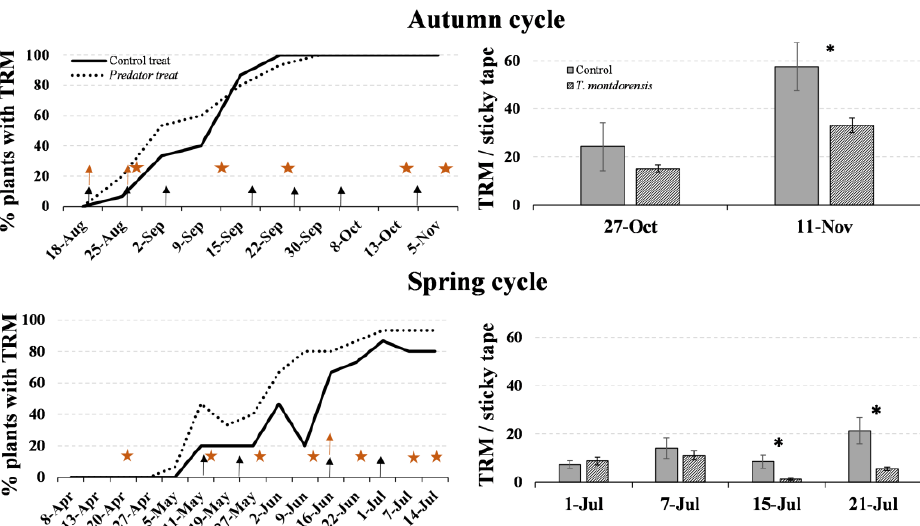
Figure 5. Percentage of plants with TRM and A. lycopersici density, measured using sticky tapes in two greenhouse tomato crop cycles, autumn 2020 and spring 2021. Arrows indicate the phytosanitary treatments against A. lycopersici that were used in each plot (black for the control and yellow for the predator treatment); yellow asterisks indicate predator releases. Black asterisks indicate significant differences between treatments ( p < 0.05).